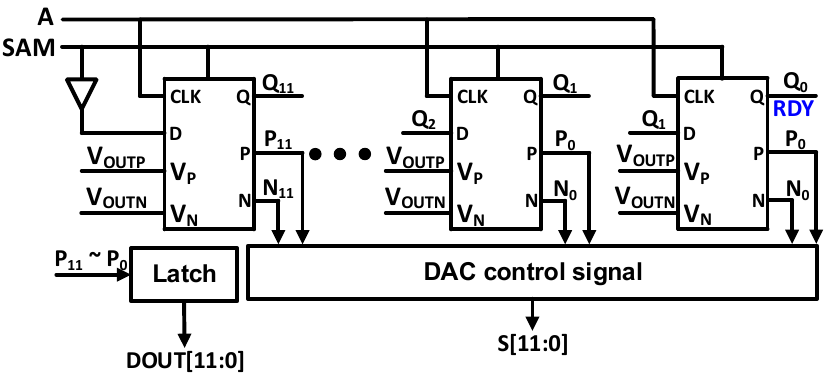
Figure 10. SAR logic block diagram.